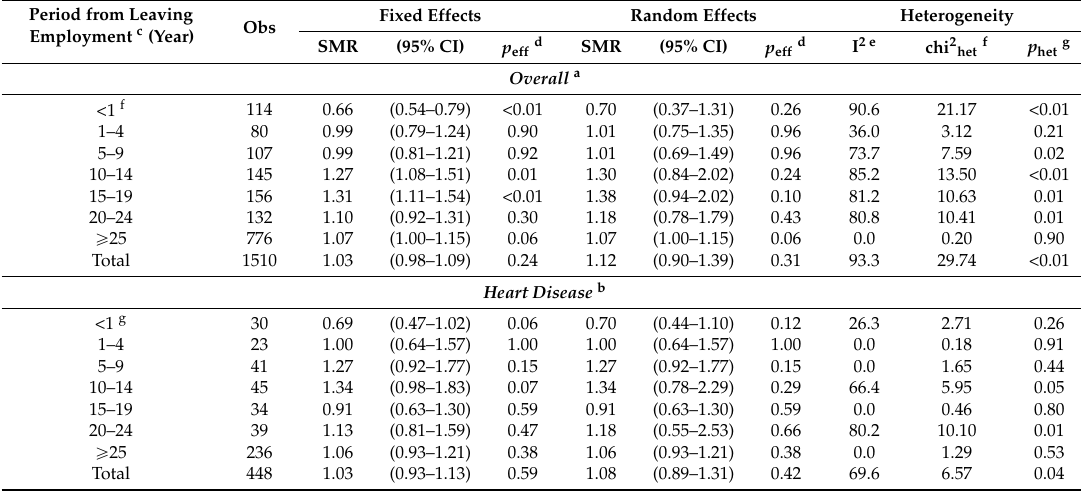
Table 6. Meta analyses of standardised mortality ratios (SMRs) for overall a and cardiac b mortality based on national rates by period from leaving employment, in carbon black production workers of three inception cohorts combined (US, UK,